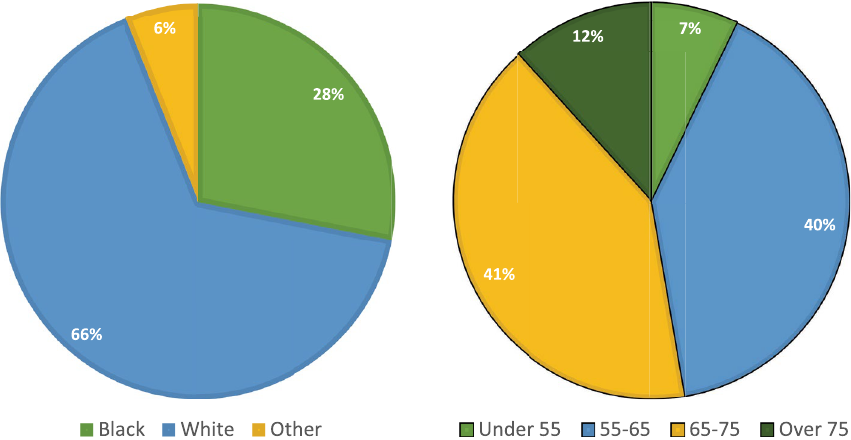
Figure 3. Distribution of race and age at diagnosis. The “Other” designation under race includes all Asian, Pacific Islander, Native American, and patients without valid race information.